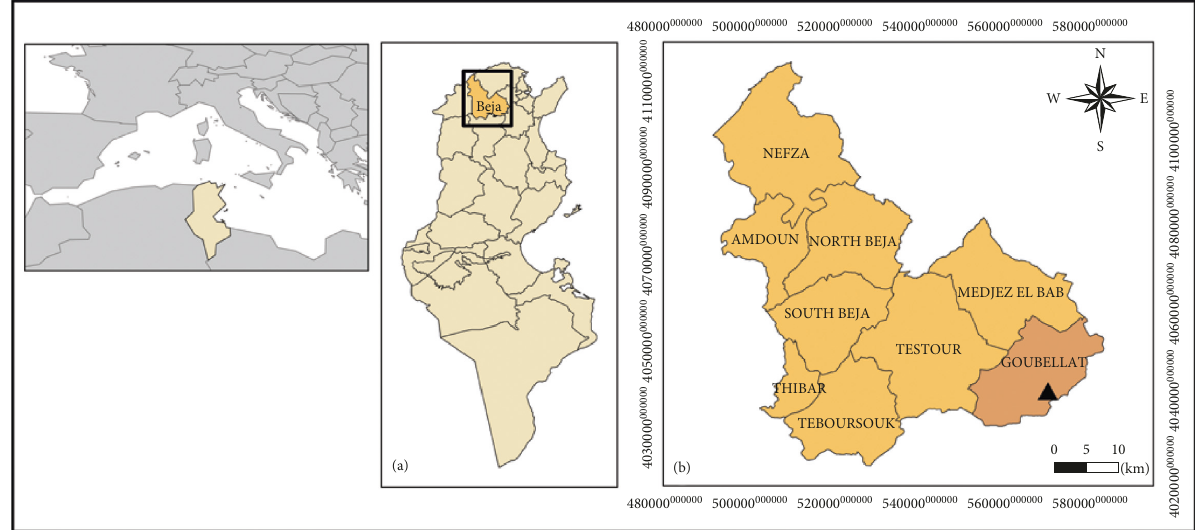
Figure 1: (a) Geographic situation of the study area. (b) Position of the studied soil